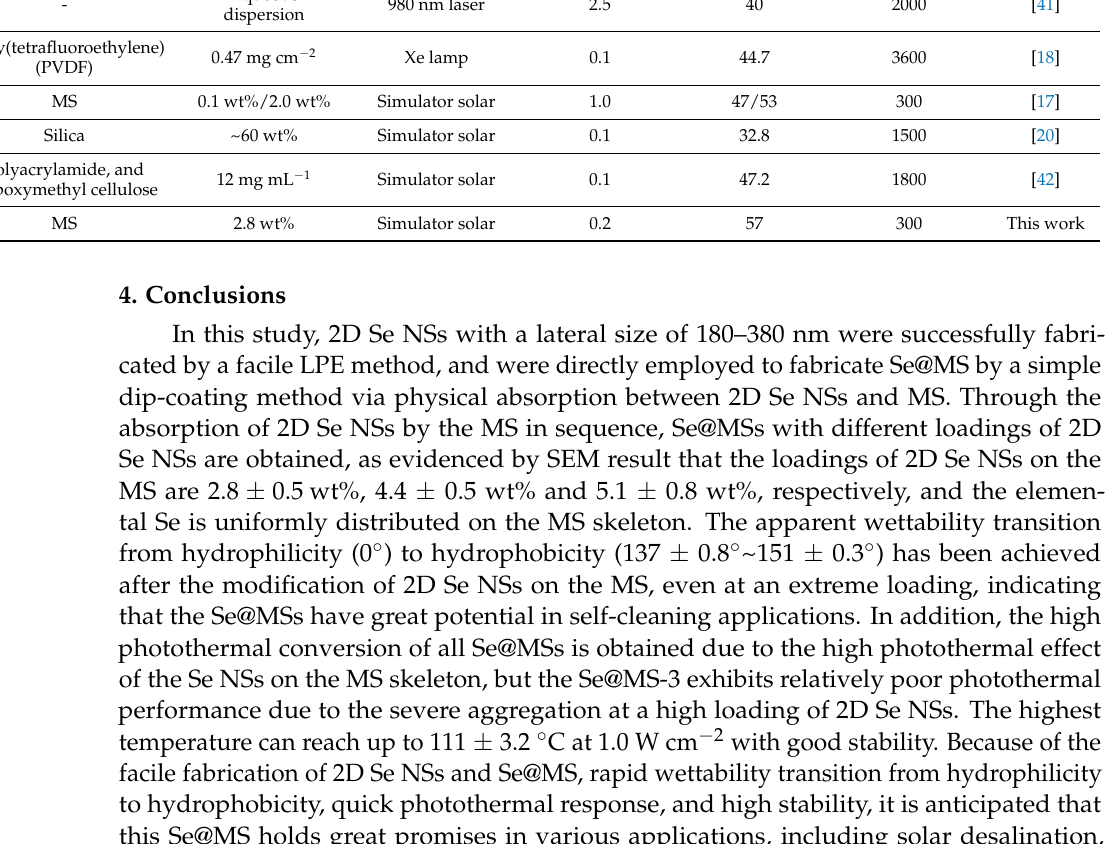
solar simulator. Figure S2: Size distribution of the Se NSs. Figure S3: N 2 Isotherm linear adsorption and desorption curves for the pristine MS, Se@MS-1, Se@MS-2, and Se@MS@-3. Figure S4: Wettability of a water droplet on the pristine MS and the as-fabricated Se@MS-3. Figure S5: Optical image of the pristine MS and Se@MS interacting with water. Figure S6: Photos of the as-fabricated Se@MS-2 before and after light illumination cycle with a power density of 1.0 W cm − 2